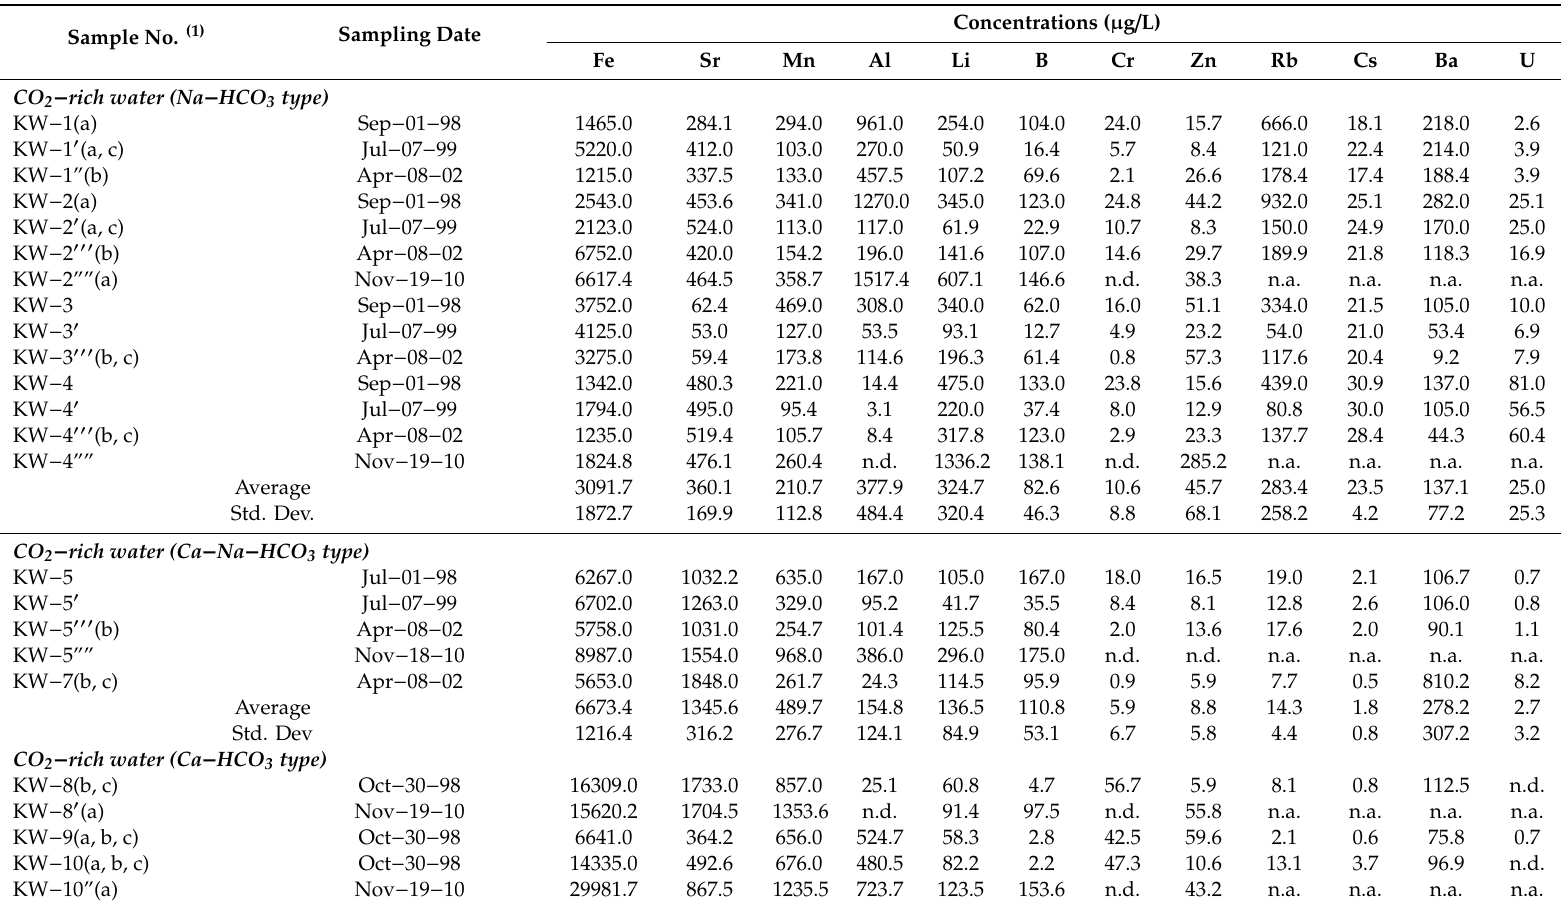
Table 2. The concentrations of minor and trace elements in water samples in the Gangwon Province of South Korea. CO 2 − rich water is grouped based on the Piper diagram (see Figure